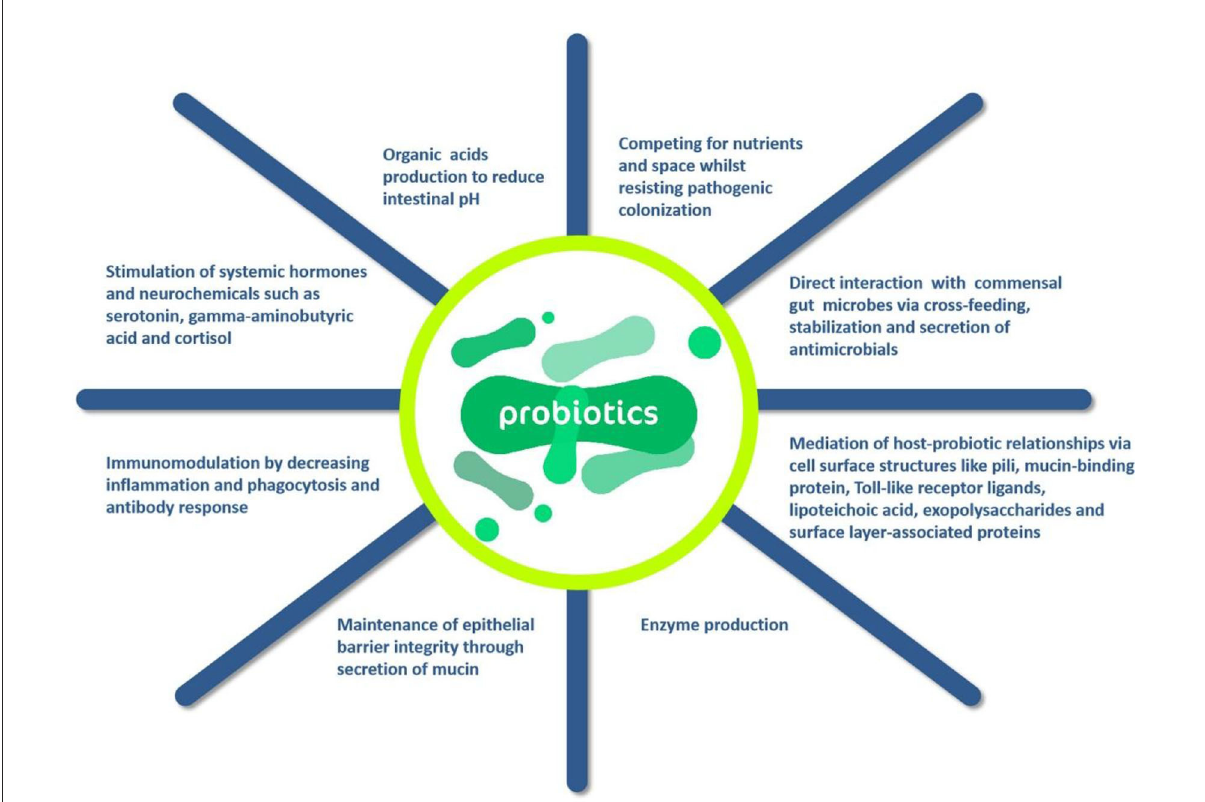
FIGURE5 Action mechanisms of probiotics